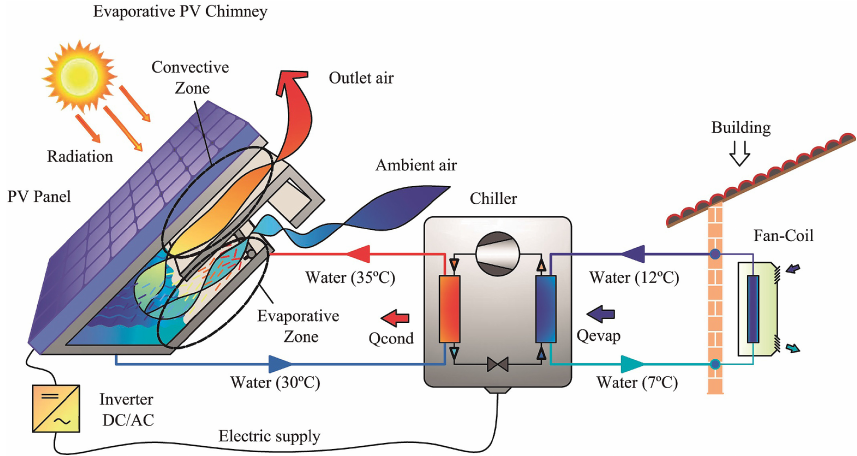
Figure 1. Evaporative PV solar chimney. Reprinted from Lucas et al. [18] with permission from Elsevier, 2017.